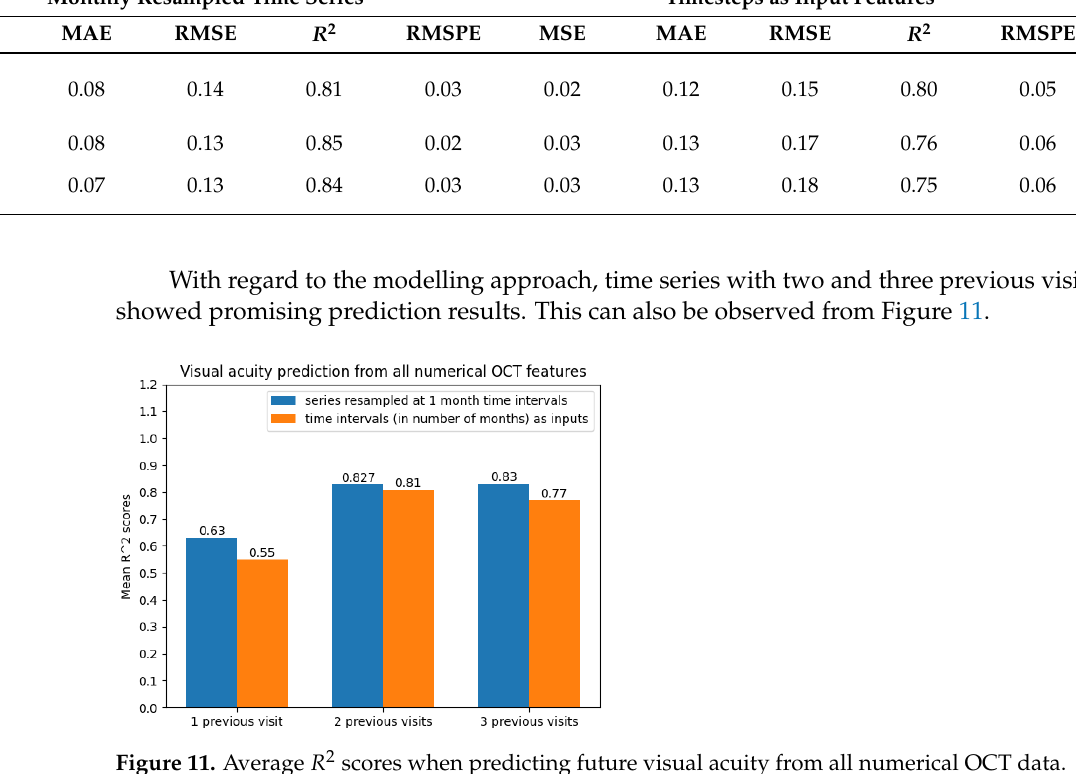
Figure 11. Average R 2 scores when predicting future visual acuity from all numerical OCT